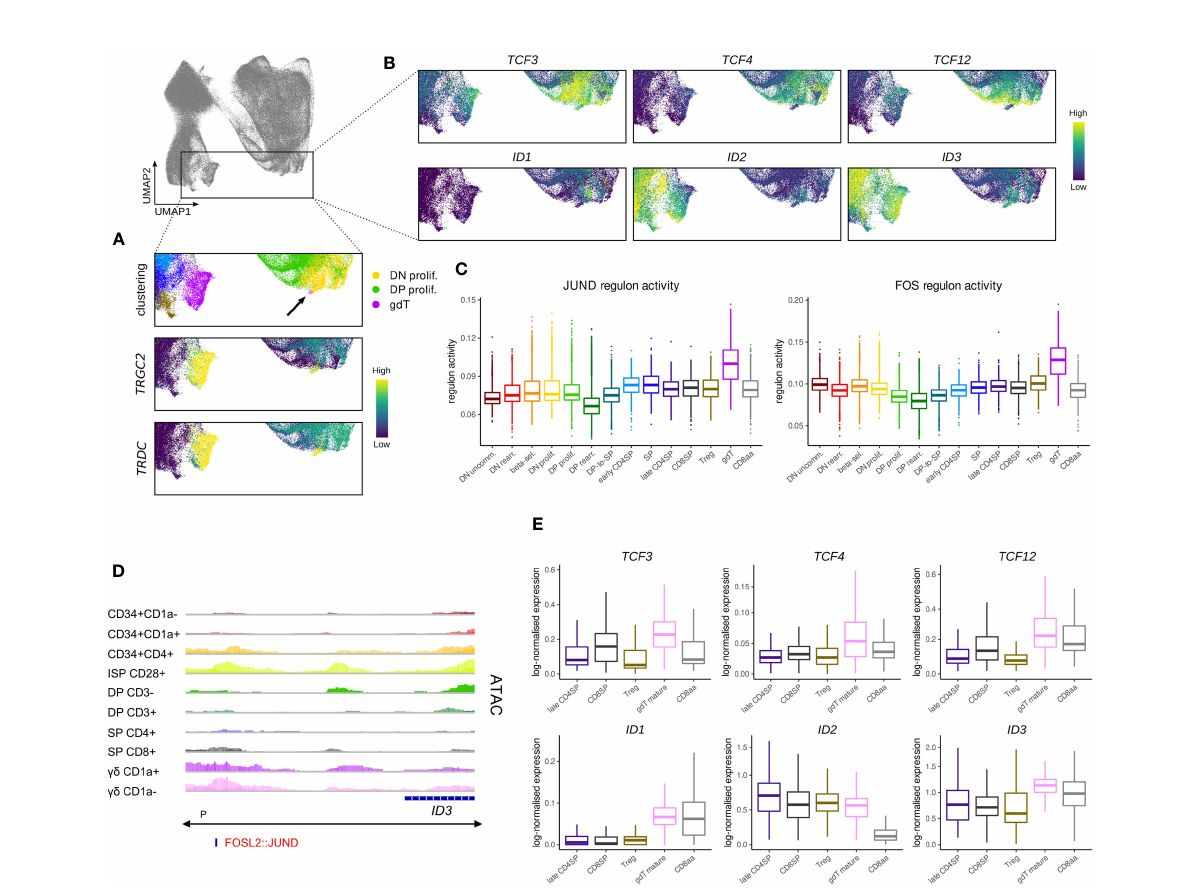
FIGURE 9 Transcription of TCF4 and TCF12 but not TCF3 is shut down in cells committing to the gd lineage. (A) UMAP visualization of TRGC2 and TRDC expression in thymocytes of the gd lineage. Annotated clusters are depicted in the top panel. (B) UMAP visualization of E and ID protein encoding genes in thymocytes of the gd lineage. (C) Activity of JUND and FOS regulons per cluster as predicted by running pySCENIC on the single cell data set. (D) Genome browser view of chromatin accessibility and AP-1 family motif at a regulatory region downstream of ID3 . Location of the ID3 promoter (P), as indicated below the gene structure, was found to span the entire locus. (E) Pseudo-bulk expression of E and ID protein encoding genes in mature thymocytes based on the single cell data set. For gd lineage cells only a subcluster of mature gd TCR + cells as indicated by low levels of CD1a was